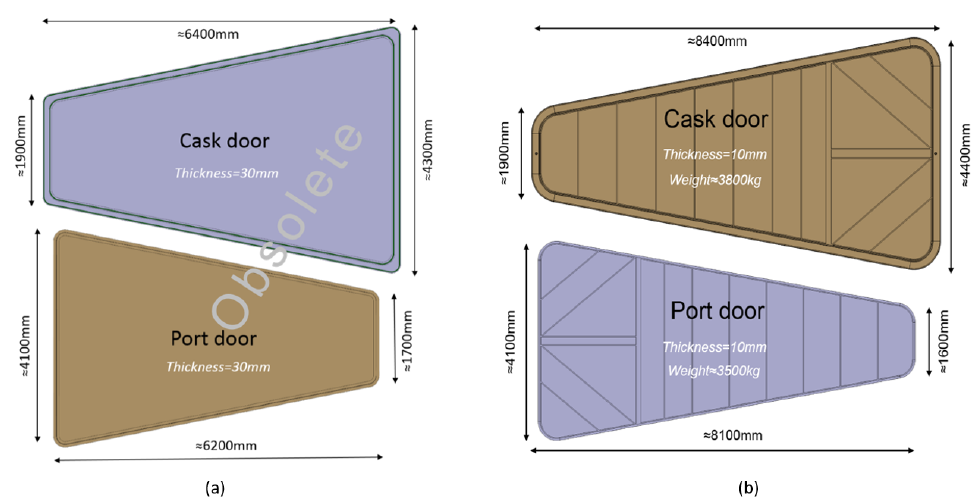
Figure 4. ( a ): Geometry model of a CCD based on the DEMO 2014 baseline and ( b ): updated geometry model of CCD from the current